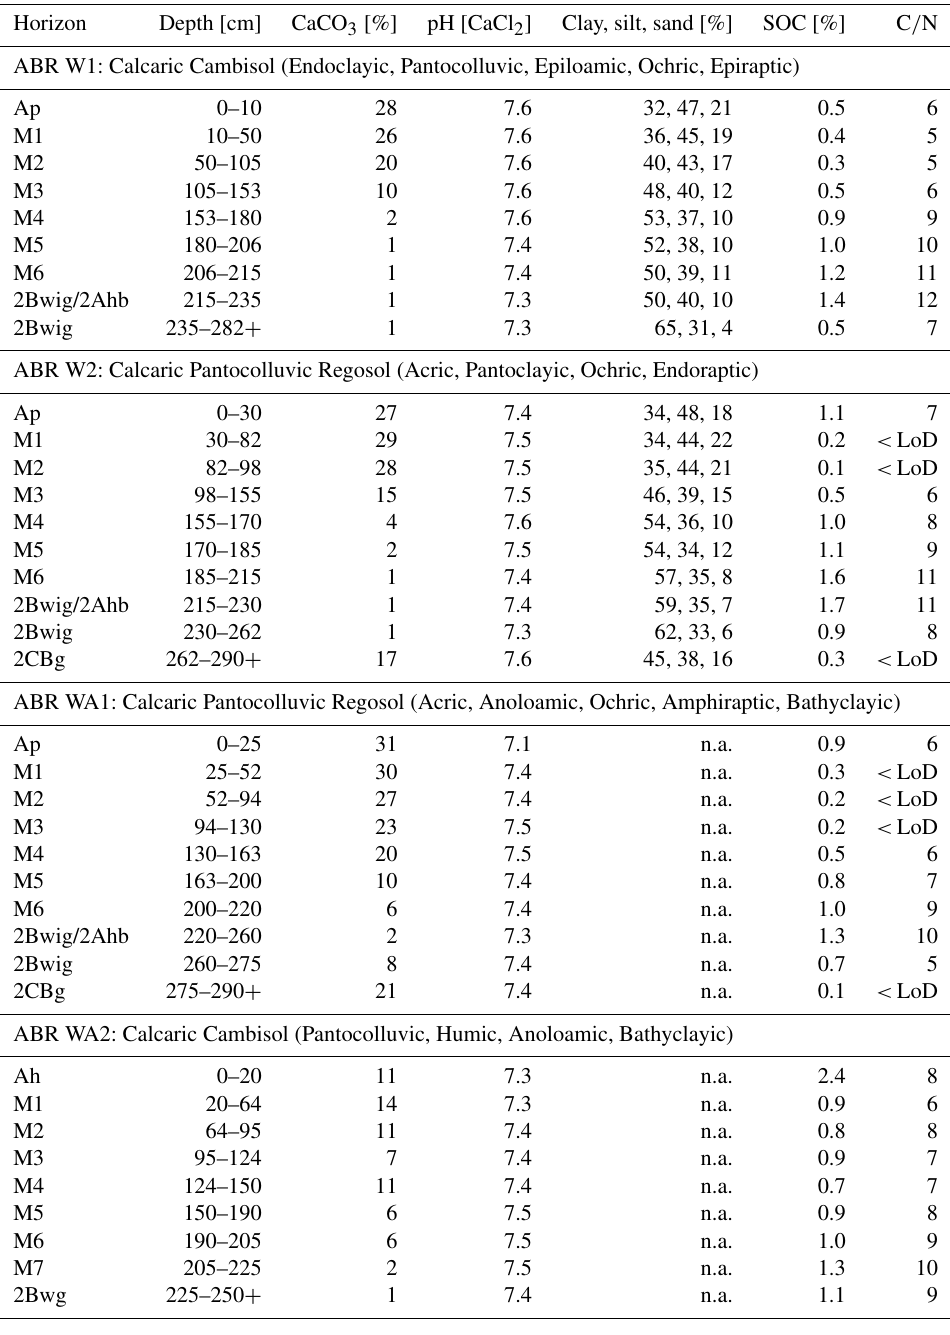
Table 1. Pedological data of selected profiles (units are given as mass in %). n.a.: not analyzed, LoD: limit of detection. Soils according to US Soil Taxonomy (family level):